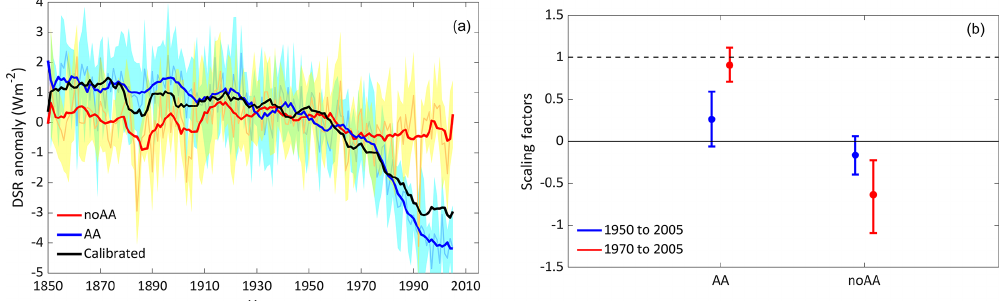
Figure 6. (a) Temporal variations of the calibrated, anthropogenic aerosol-driven (AA-driven) and noAA-driven DSR. Temporal variations were averaged by a 10-year moving window to remove the impact of annual variability. The shaded area is the standard deviation of model average. (b) Scaling factors of the AA and noAA forcing simulation on DSR based on optimal fingerprinting method. The p value of the impact factor in 1950–2005 (1970–2005) is 0.22 (0.04).